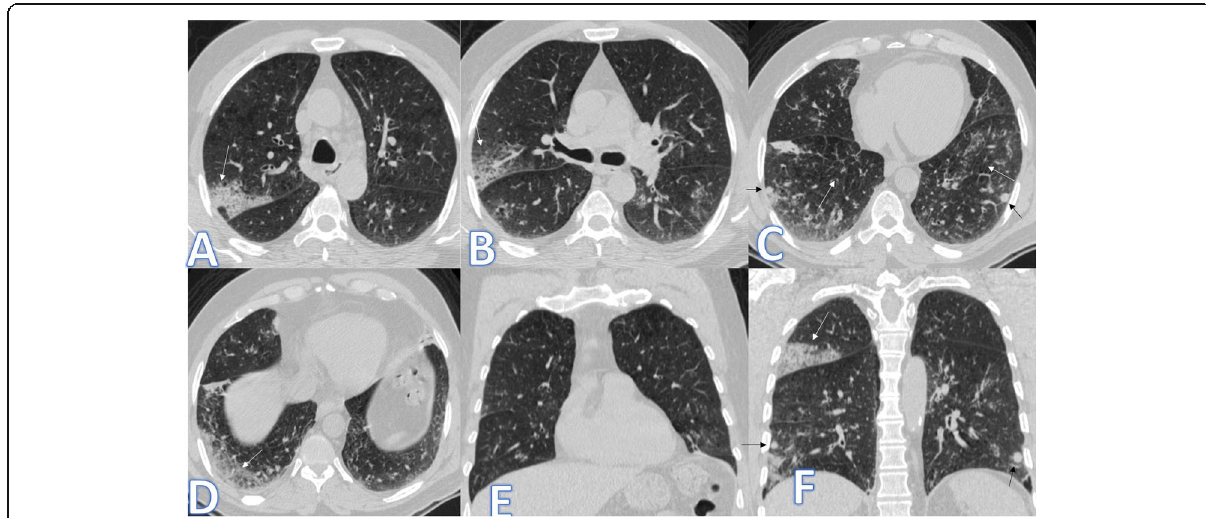
Fig. 14 A 65-year-old male patient presented with dyspnea and low-grade fever. CT chest showed bilateral scattered mainly peripheral consolidative patches with faint GGO (white arrows), associated bilateral basal interlobular septal thickening with small nodules (black arrows). The diagnosis was amidarone lung toxicity